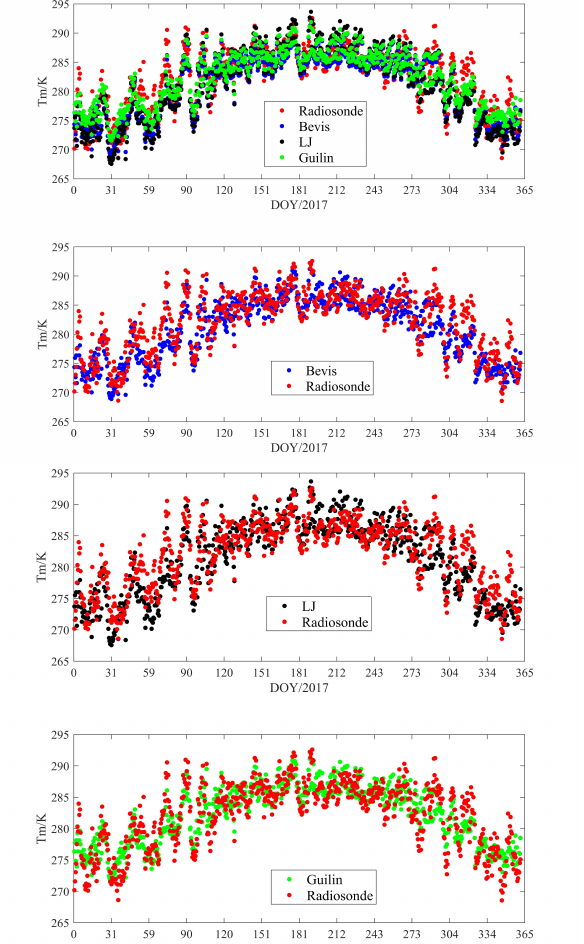
Figure 3. Comparison of T m values of the 3 kinds of models and reference values